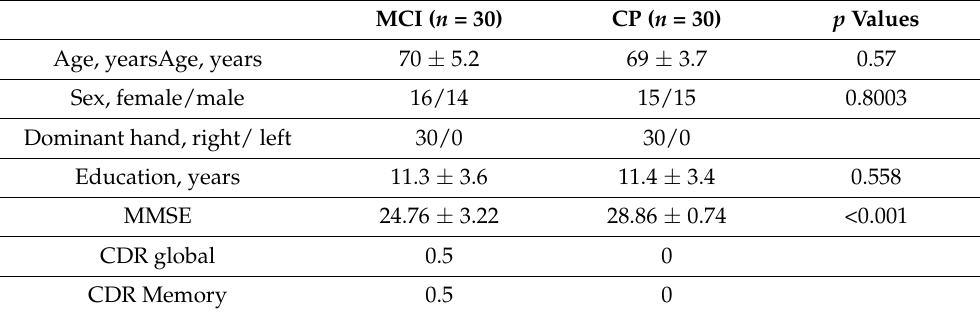
Table 1. Sample demographics and characteristics of control participants and the MCI group. MCI ( n =